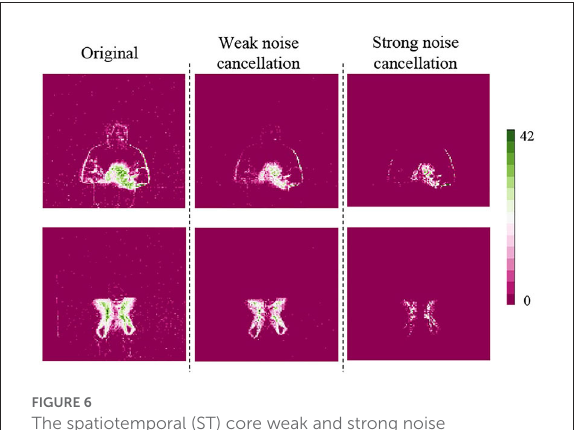
FIGURE6 The spatiotemporal (ST) core weak and strong noise cancellation results.